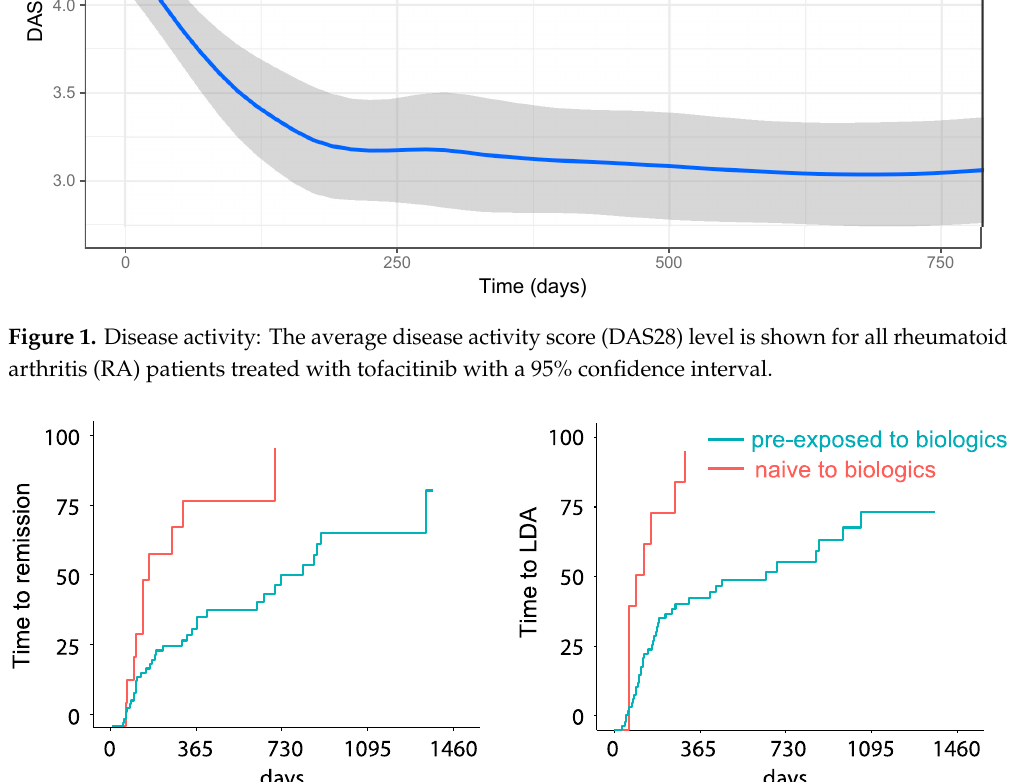
Table 2. Reasons for stopping tofacitinib.